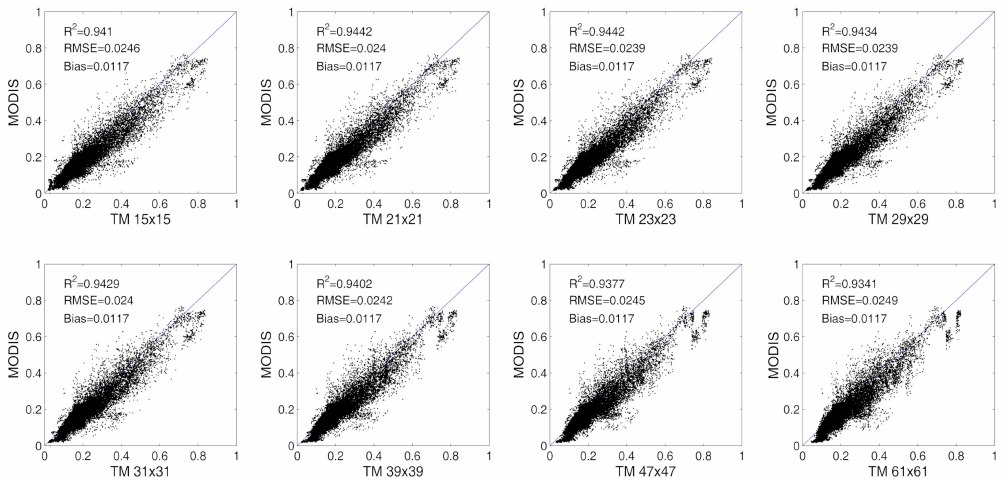
Figure 5. Comparison between MODIS albedo data with TM data aggregated at ( a ) 15 × 15, ( b ) 21 × 21, ( c ) 23 × 23, ( d ) 29 × 29, ( e ) 31 × 31, ( f ) 39 × 39, ( g ) 47 × 47, and ( h ) 61 × 61 scales.